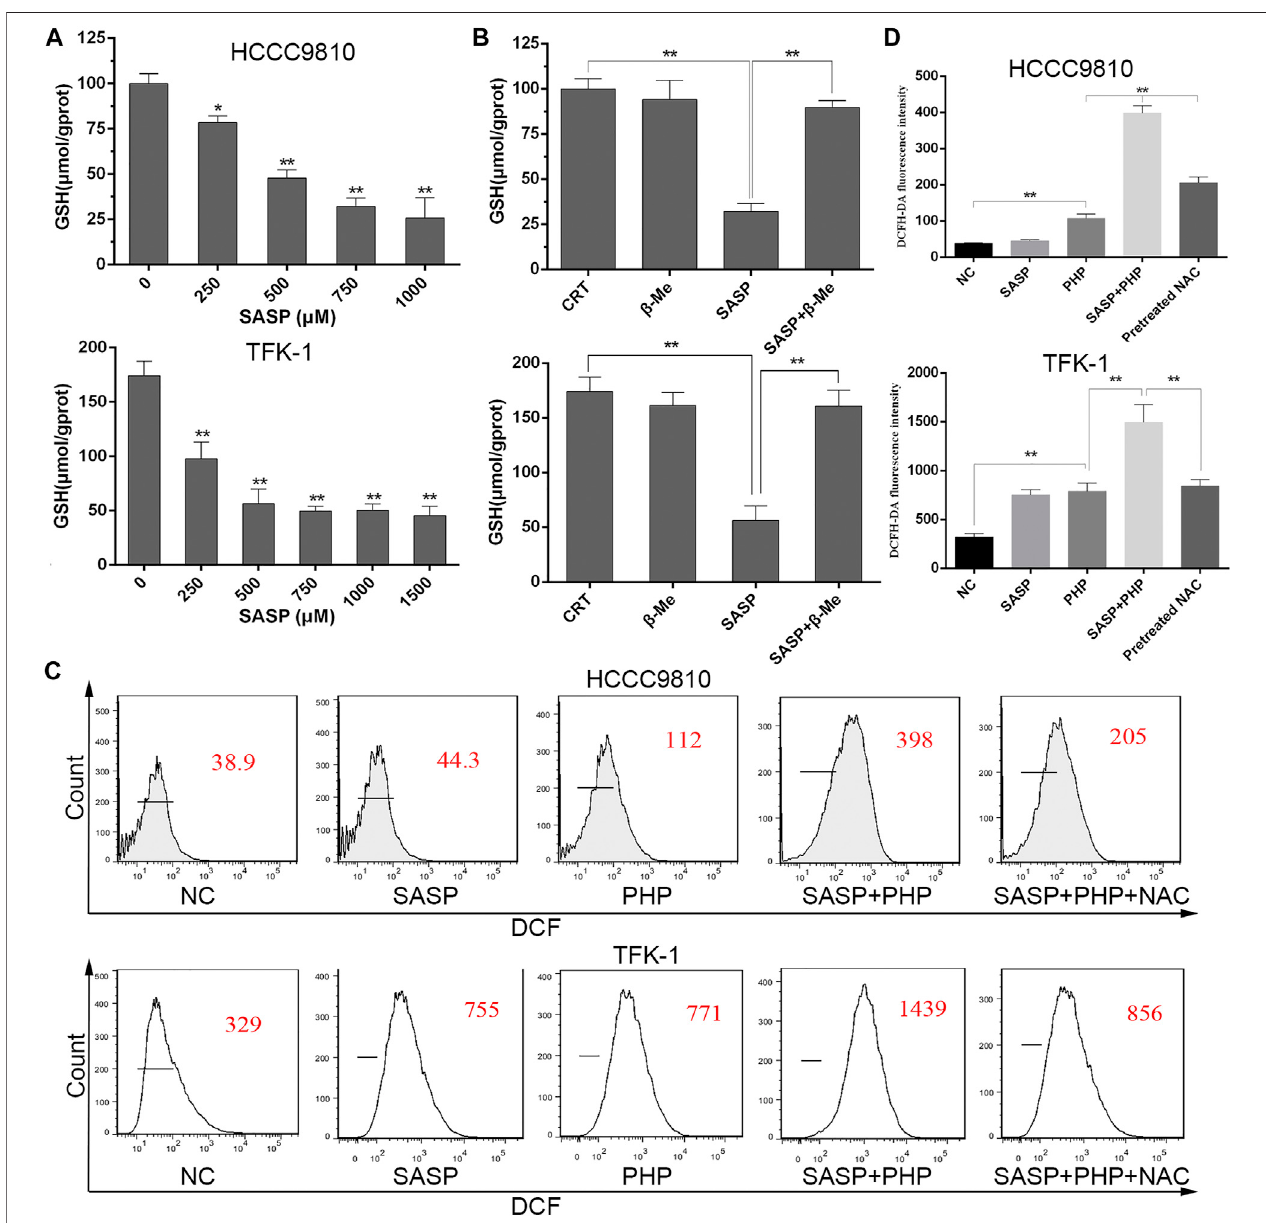
FIGURE 5 | SASP down-regulates the GSHlevel in CCA cells. (A) Intracellular GSH level in HCCC-9810(upperpanel)and TFK-1 (lowerpanel)cells after treatment with variousconcentrationsofSASP. (B) IntracellularGSHlevelinHCCC-9810(upperpanel)andTFK-1(lowerpanel)cellsafterSASPtreatmentinthepresenceorabsenceof β -ME. (C,D) FlowcytometrychartandhistogramsofROSlevelsaftertreatmentwithSASP(0.5 mM),PHP-PDT(12 μ g/ml,10 J/cm2)andtheircombinationinHCCC-9810andTFK-1 cells,respectively.Pre-treatmentwith 5 mMN-acetyl-L-cysteine(NAC) signi fi cantlyreducedtheROSlevelsinduced bythecombinationtreatment. * p < 0.05,** p < 0.01.